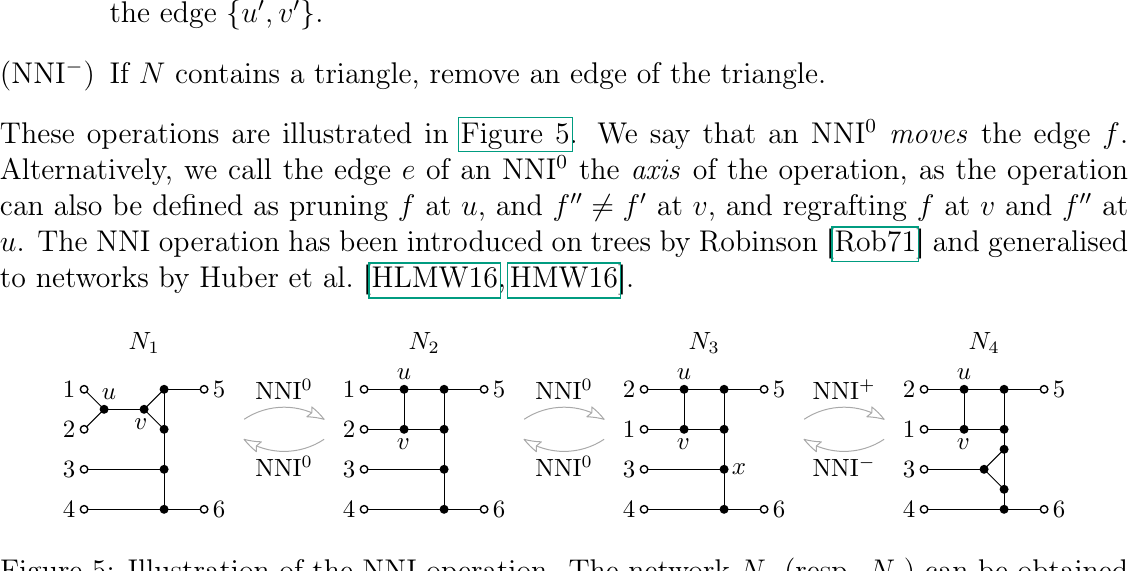
Figure 5: Illustration of the NNI operation. The network N from N (resp. N ) by an NNI 0 with the axis { u, v } ; alternatively, N 1 2 from N using the NNI 0 of { 1 , u } to the triangle, and N 1